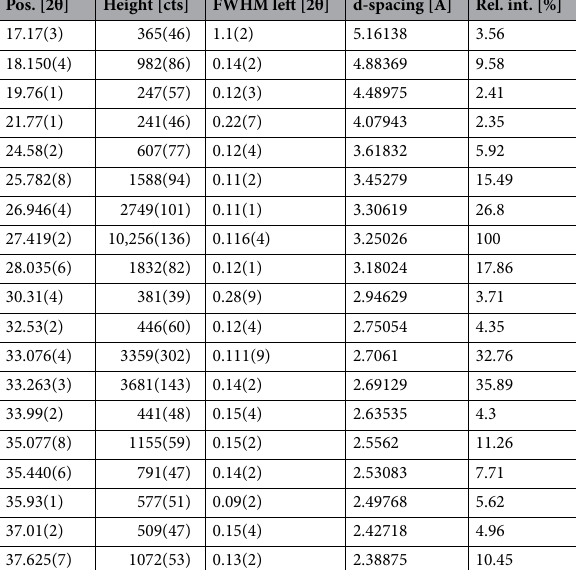
Table 4. The details of crystal planes for 10 wt% PC/Bi 2 O 3